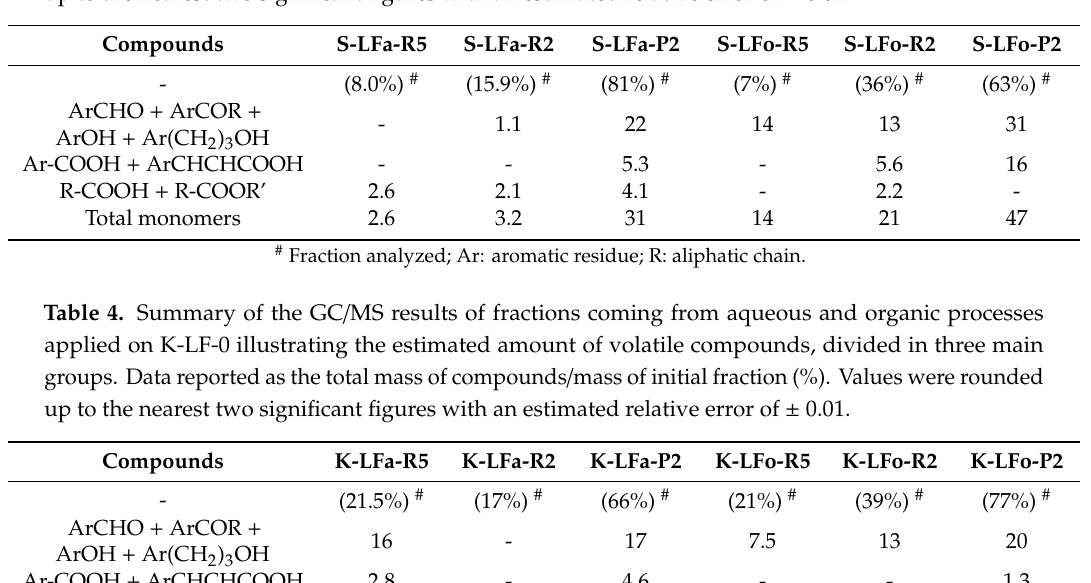
Figure 5. GFC chromatograms of selected soda ( a , b ) and kraft ( c , d ) lignin fractions recovered from the aqueous process ( a , c ) and the organic process ( b , d ). Table 3. Summary of the GC / MS results of fractions coming from aqueous and organic processes applied on S-LF-0 illustrating the estimated amount of volatile compounds, divided in three main groups. Data reported as the total mass of compounds / mass of initial fraction (%). Values were rounded up to the nearest two significant figures with an estimated relative error of ± 0.01.